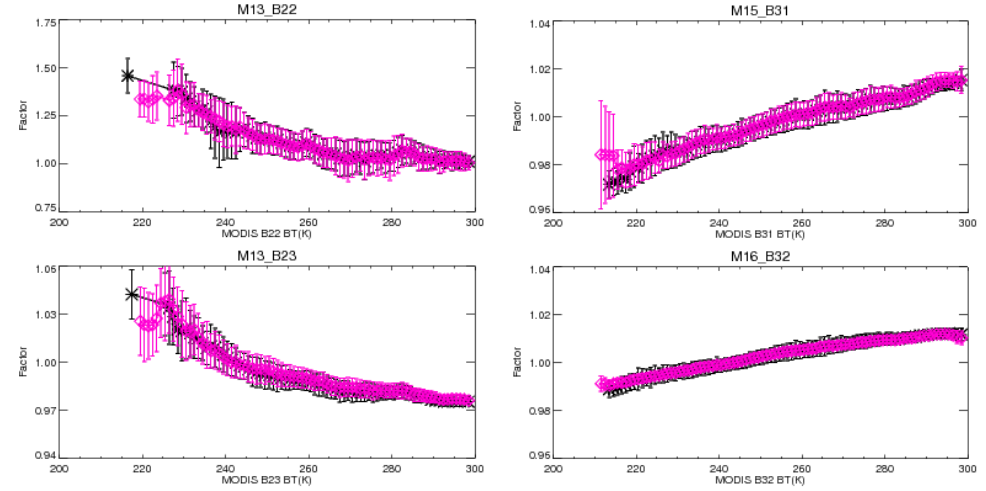
Figure 7. RSR correction factors from AIRS (black stars) and CrIS (blue diamonds) measurements. The SNO data was also analyzed in radiance. Instead of the absolute radiance difference, it is expressed as a percentage. Table 4 summarizes the percent differences of radiance before and after the RSR correction. For longer wavelength bands, after the RSR correction, the differences of VIIRS(M15)-MODIS(B31) and VIIRS(M16)-MODIS(B32) are within 0.1% and 0.2%, respectively, except at very low radiance of 1.0 W/m ^ 2/ μ m/sr.